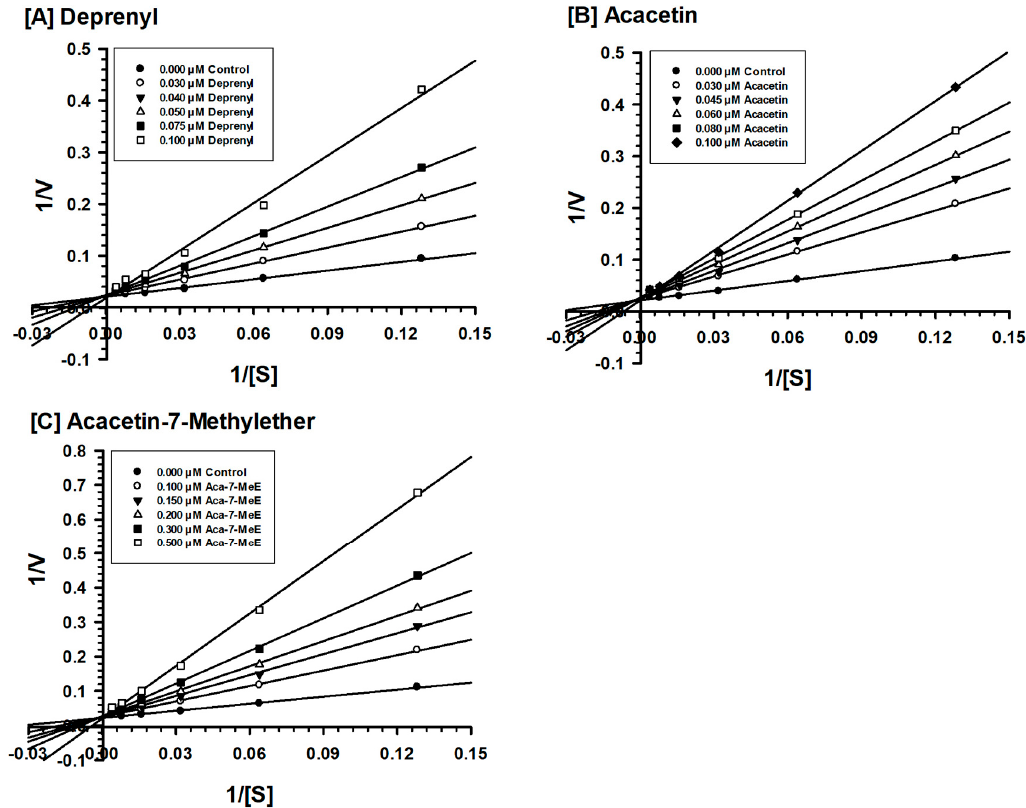
Figure 3. Kinetics characteristics of inhibition of recombinant human MAO-B by ( A ) deprenyl, ( B ) acacetin and ( C ) acacetin 7-methyl ether. Each point shows the mean value of three observations. Table 2. Inhibition/binding affinity constants (Ki) for inhibition of recombinant human MAO-A and MAO-B by acacetin, acacetin 7-methyl ether, and deprenyl. Monoamine Oxidase-B Compounds